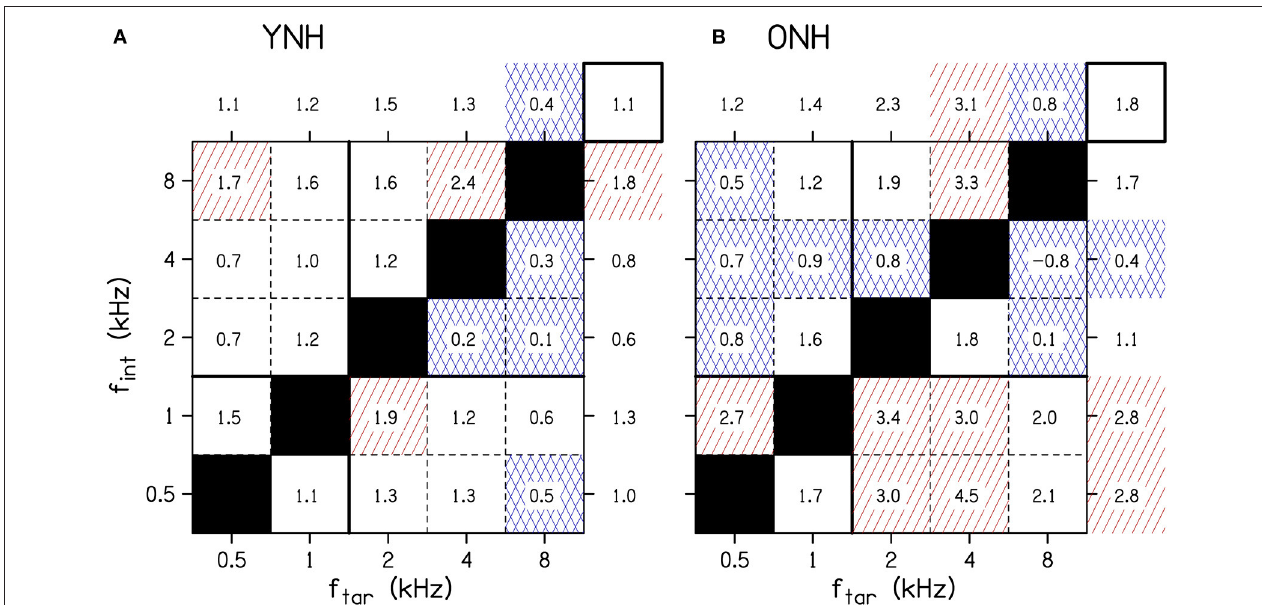
FIGURE 4 | The average amount of binaural interference for YNH (A) and ONH (B) listeners. The numbers in the boxes represent the binaural interference index for target and interferer frequency combinations in dB. The numbers outside of the main grid are the average of each column and row. The overall average interference across all conditions is shown by the number in the top right box of each panel. Cells highlighted by red diagonal lines denote a relatively large amount of binaural interference, defined as at least 50% greater than the overall average. Cells highlighted by blue crossed lines denote a relatively small amount of binaural interference, defined as at least 50% less than average. The solid horizontal and vertical lines between 1 and 2kHz show the border where low-frequency ITDs are particularly potent. f int , interferer frequency; f tar , target frequency; ONH, older normal hearing; YNH, younger normal hearing. The YNH data have been previously reported. Reproduced from Beth Rosen and Matthew J. Goupell, “The effect of target and interferer frequency on across-frequency binaural interference of interaural-level-difference sensitivity,” J. Acoust. Soc. Am. 151, 924–938 (2022), https://aip.scitation.org/doi/10.1121/10.0009398, with the permission of Acoustical Society of